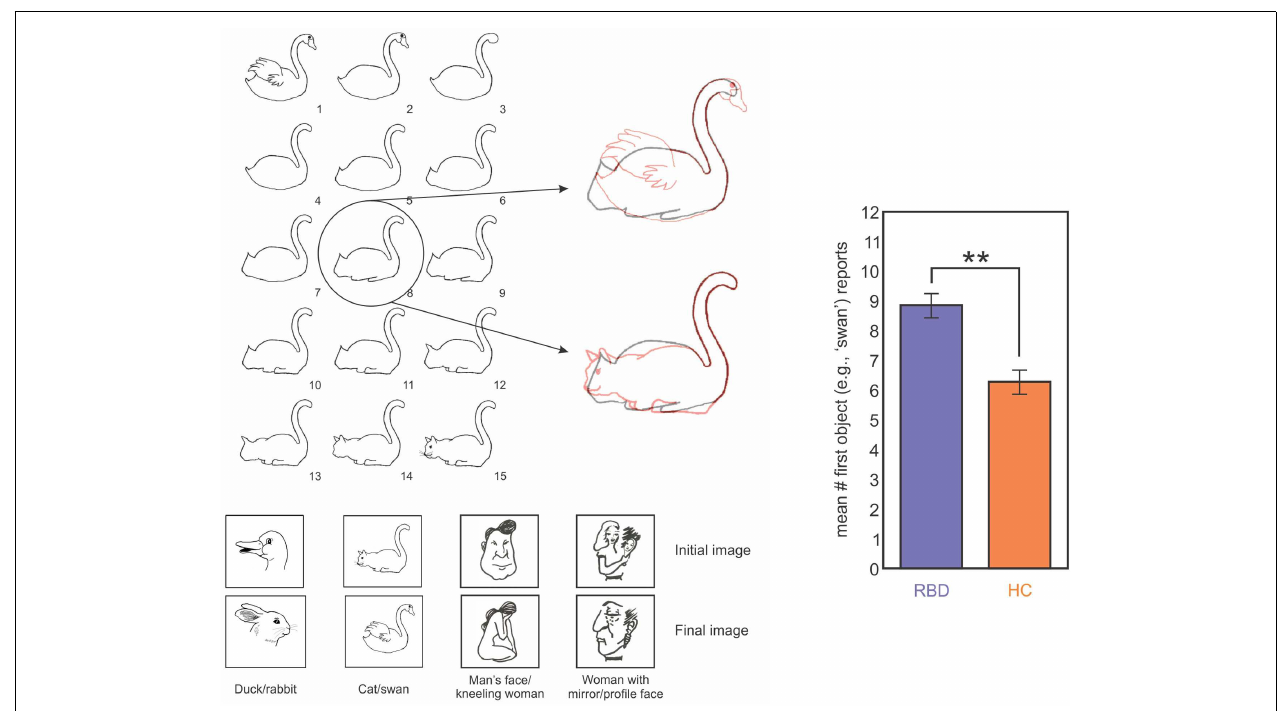
from RBD (purple) and HC (orange) participants showing mean report of the first object (i.e., how long does the first perceptual model persist before participants switch to the second?). RBD patients reported the first object for significantly more trials than did HCs (Stoettinger et al., under review).